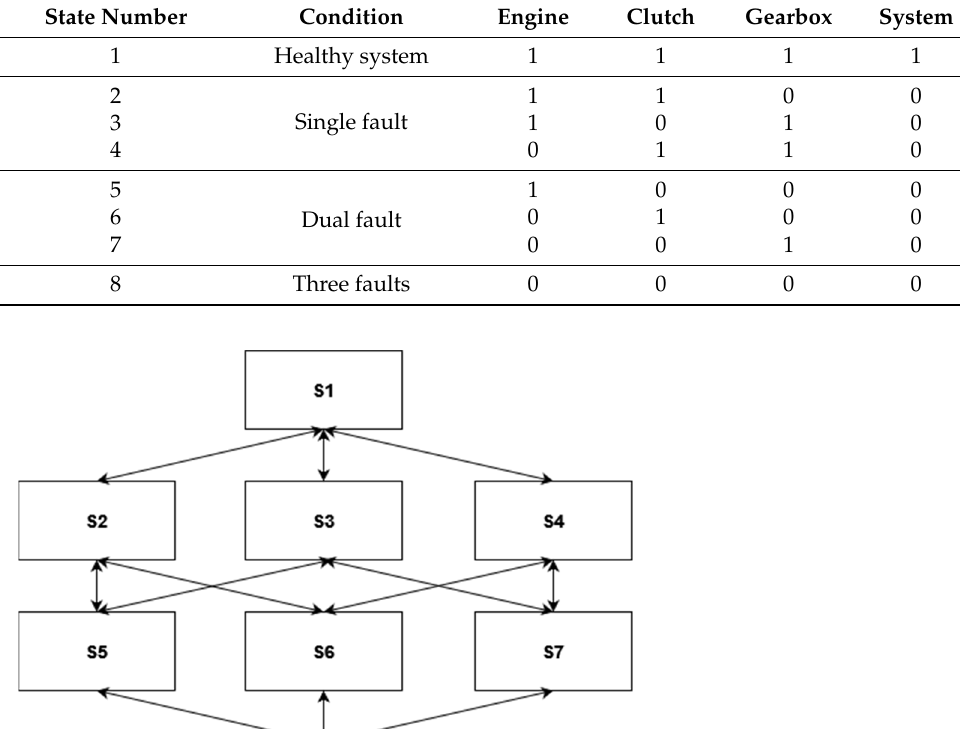
Table 5. States of the conventional system.